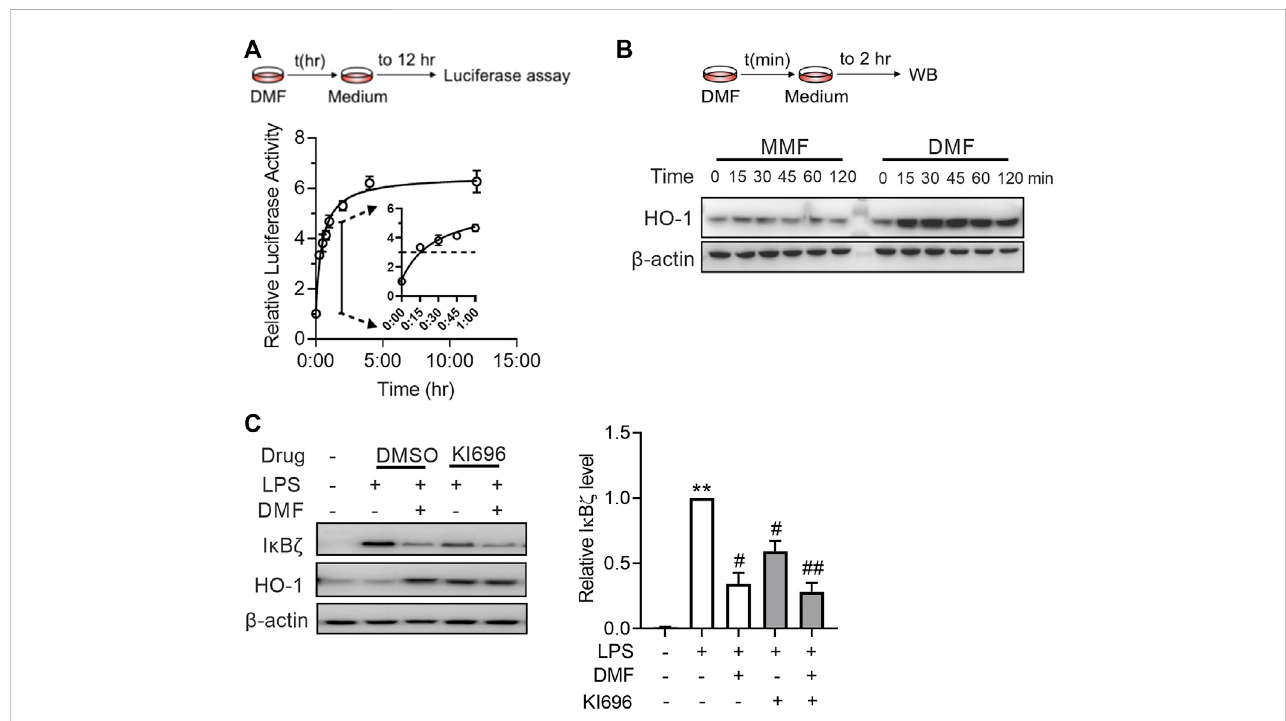
FIGURE 6 DMF inhibited LPS-induced I κ B ζ expression by rapid Nrf2 activation. (A) HEK293-ARE reporter cells were treated with 40 μ M DMF for the indicated time and then cultured in DMF-free medium for a total of 12 h. A luciferase assay was applied to evaluate Nrf2 activation ( n = 3). (B) RAW264.7 cells were treated with 40 μ M DMF for the indicated time and then cultured in DMF-free medium for 2 h. Western blot analysis of HO-1 from the indicated groups. (C) RAW264.7 cells were treated with 10 μ M KI696 for 24 h and then 40 μ M DMF for 1 h, followed by a 1-h LPS stimulation. Western blot analysis and quanti fi cationofI κ B ζ intheindicatedgroups( n =3).** p < 0.01 vs.theuntreatedgroupbyone-wayANOVA; # p < 0.05 , ## p < 0.01 vs.theLPSgroupbyone-way